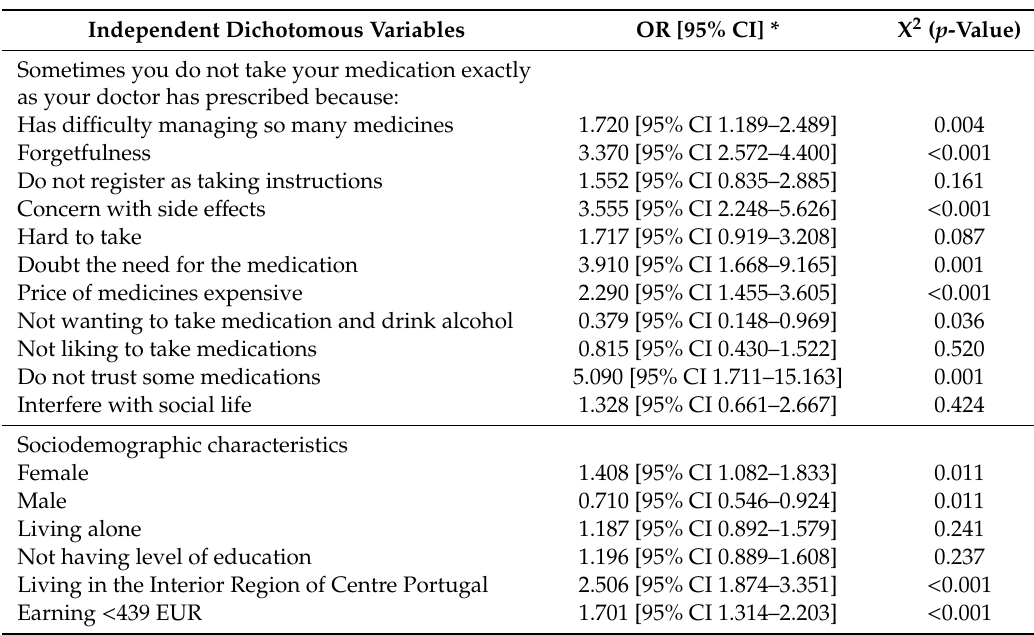
Table 7. Factors influencing medication